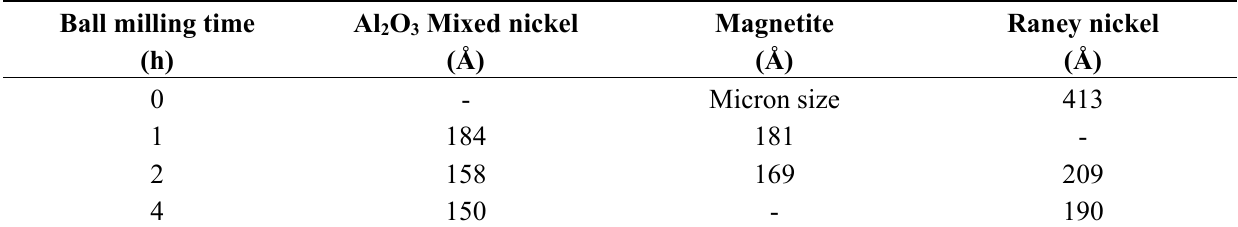
Table 1. Crystallite size of variously ball milled catalysts.